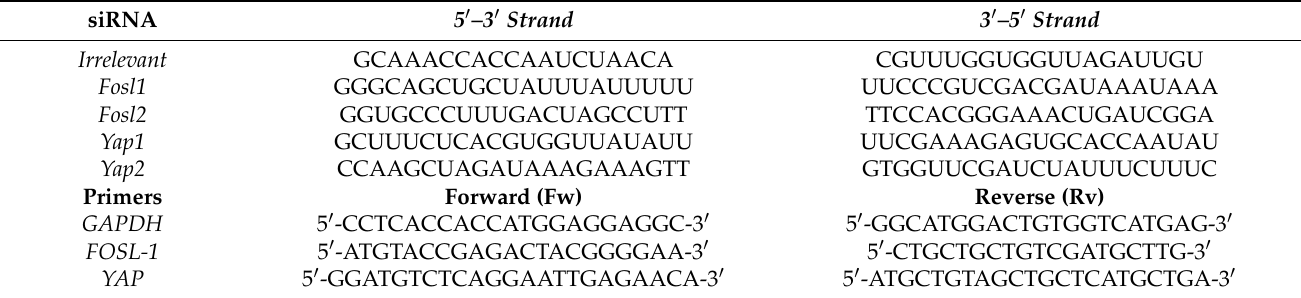
Table 1. Nucleotide sequences of the different siRNAs used for the inhibition of the FOSL-1 and YAP mRNA and protein expression, and the primers used for